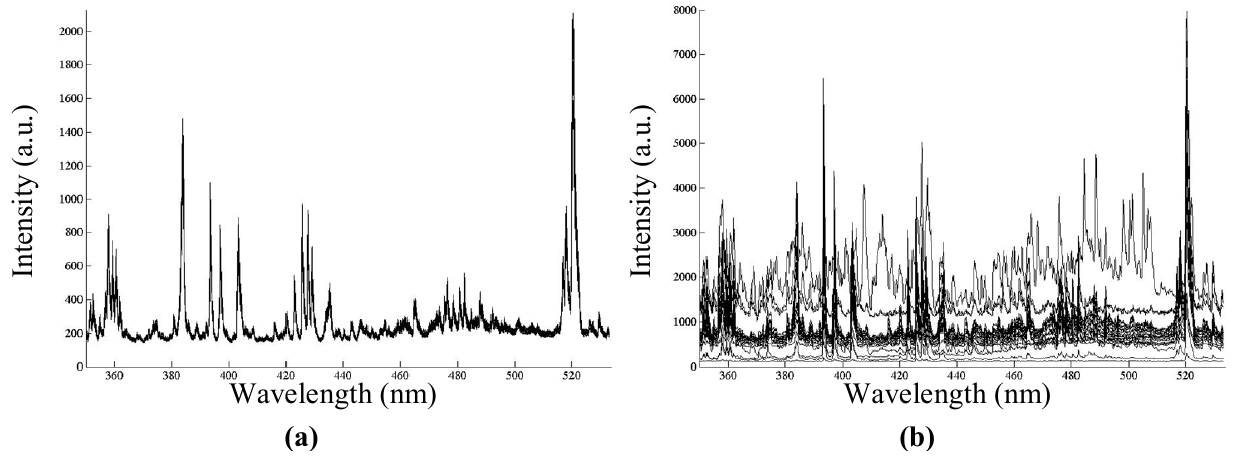
Figure 2. Spectral curves of: (a) several correct seams. (b) distinct